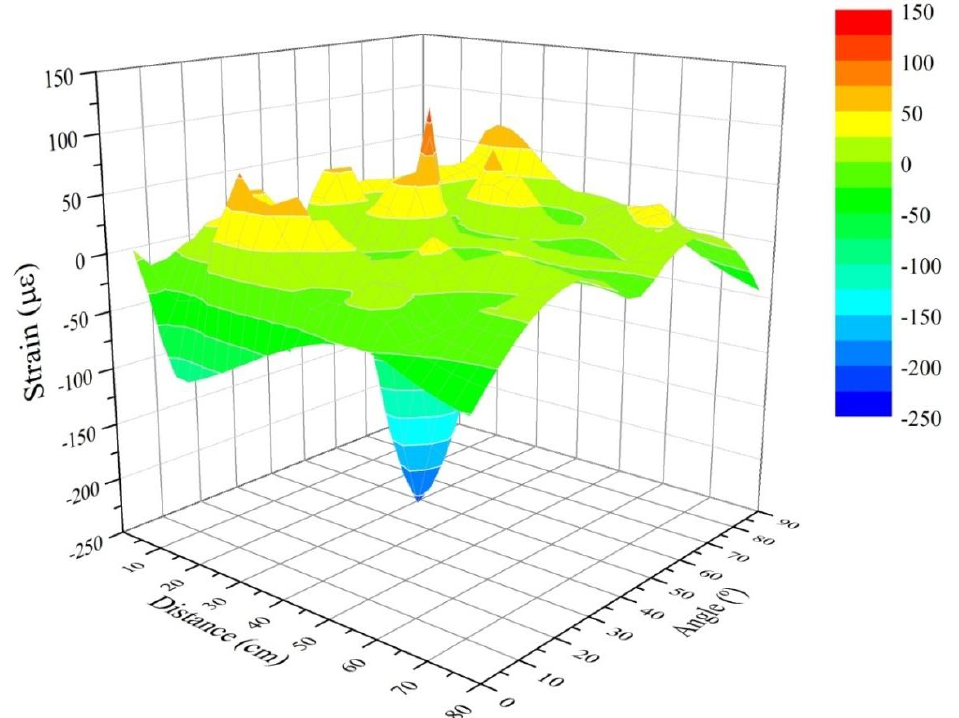
Figure 6. Residual strain with the mass of 10